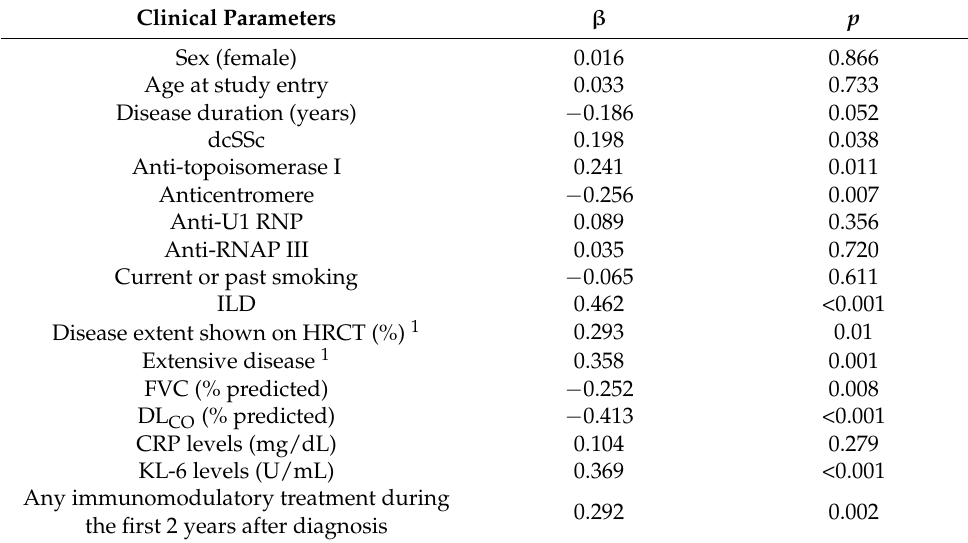
Table 2. Simple regression analysis to identify the factors associated with variability of KL-6 levels over 2 years in 110 patients with